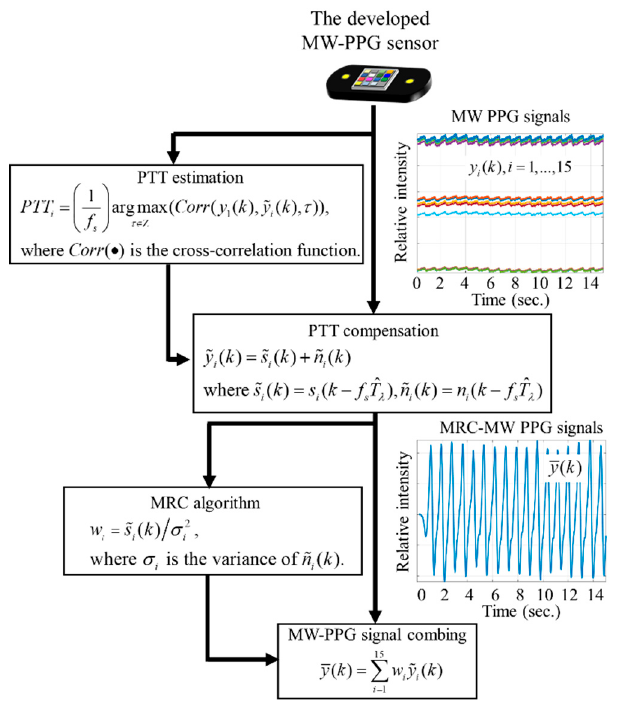
Figure 3. The developed signal processing flowchart for extracting robust maximal-ratio combined (MRC)-MW-PPG signals. 165